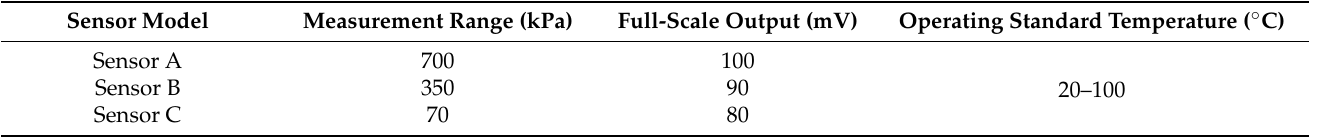
Table 1. Sensor models and their